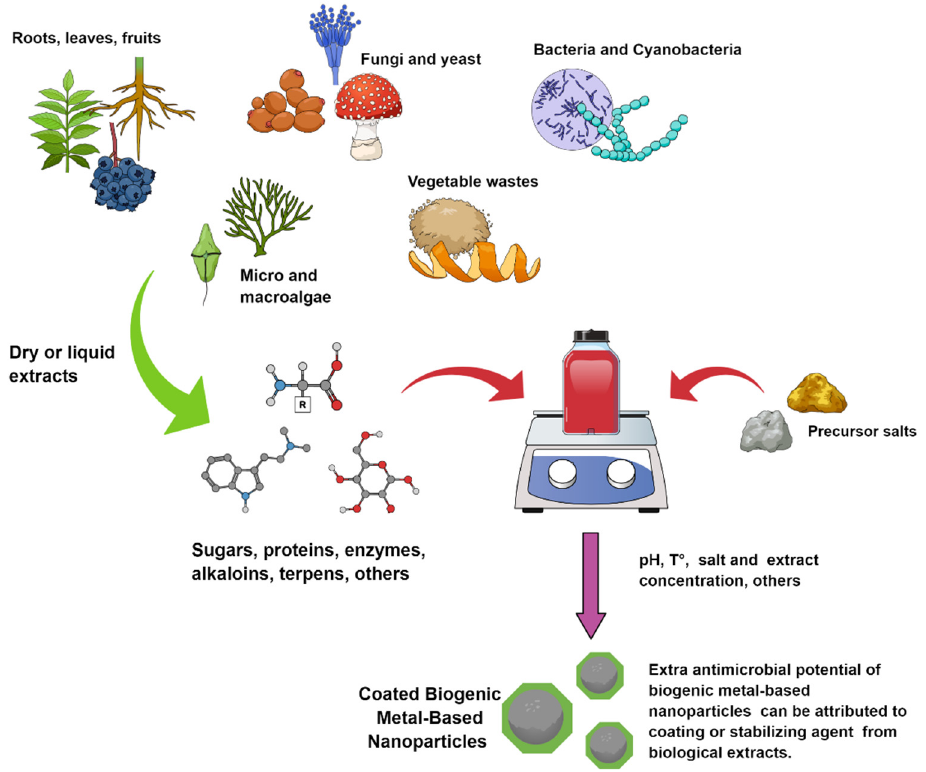
Figure 1. Main biological sources used to prepare biogenic metal-based NPs.